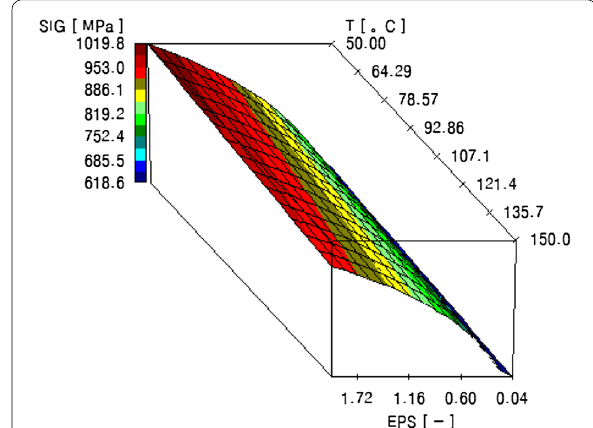
Figure 9 Strain-flow stress curve of 34CrMo4 according to the temperatures